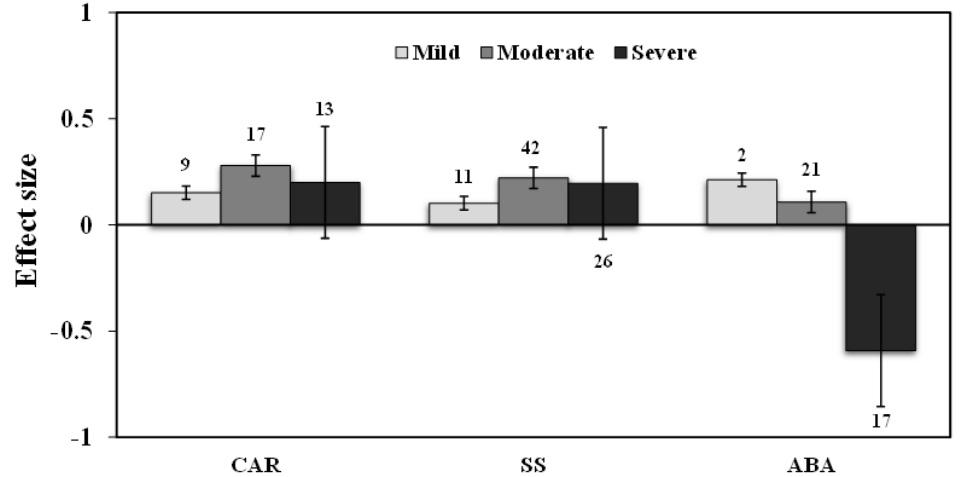
Figure 7. Effect of drought stress on CAR, SS, and ABA levels in AMF inoculated plants. Error bars are means ± 95% confidence intervals (CIs). Where the CIs do not overlap the horizontal lines, the effect size for a response variable is significant at p < 0.05. The numbers of observations are shown above the bar. Note: CAR − Carotenoids, SS − Soluble sugars, ABA − Abscisic acid.